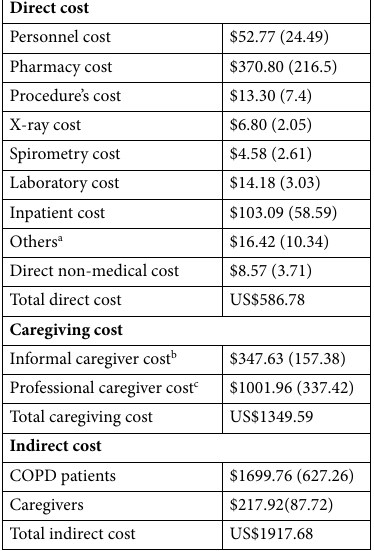
Table 2. Societal and economic burden of COPD patients and their caregivers. All costs in US$ (United States dollar); 1US$ = 4.13MYR on September 18, 2019; mean (standard deviation); COPD, Chronic obstructive pulmonary disease. a Others, (cleaning, electricity, communication, building maintenance, and depreciation cost). b 64.66% of COPD patients were depending on informal caregivers. c 7.1% of COPD patients utilised professional healthcare services at home.